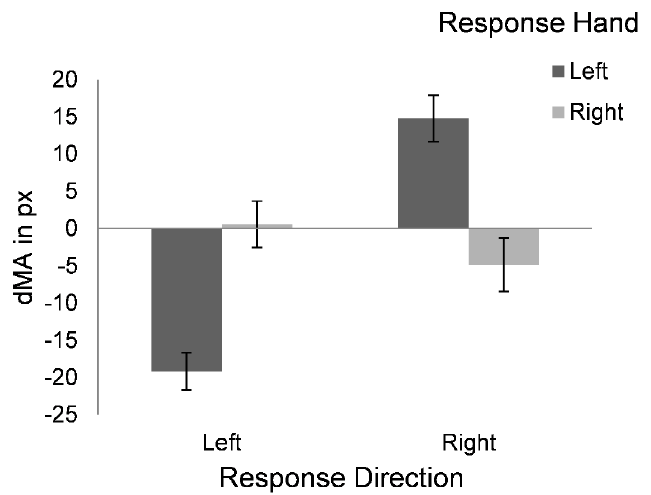
Figure 6. MARC effects for MA in the parity judgment task separated by response direction and response hand. The MARC effects are depicted as differences in MA between odd and even numbers (dMA = MA even numbers minus MA odd numbers). Positive values indicate a regular MARC effect (larger responses to even compared to odd numbers), whereas negative values indicate a reversed MARC effect (larger responses to odd compared to even